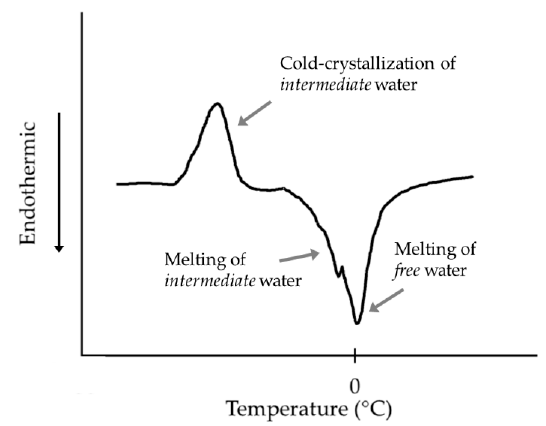
Figure 3. Scheme of a differential scanning calorimetry (DSC) thermogram of a hydrated surface with three states of water. Non-freezable water not visible in the thermograms. Modified from [26]. Reprinted by permission from Macmillan Publishers Ltd.: Polymer Journal 45: 701–710, copyright 2013.